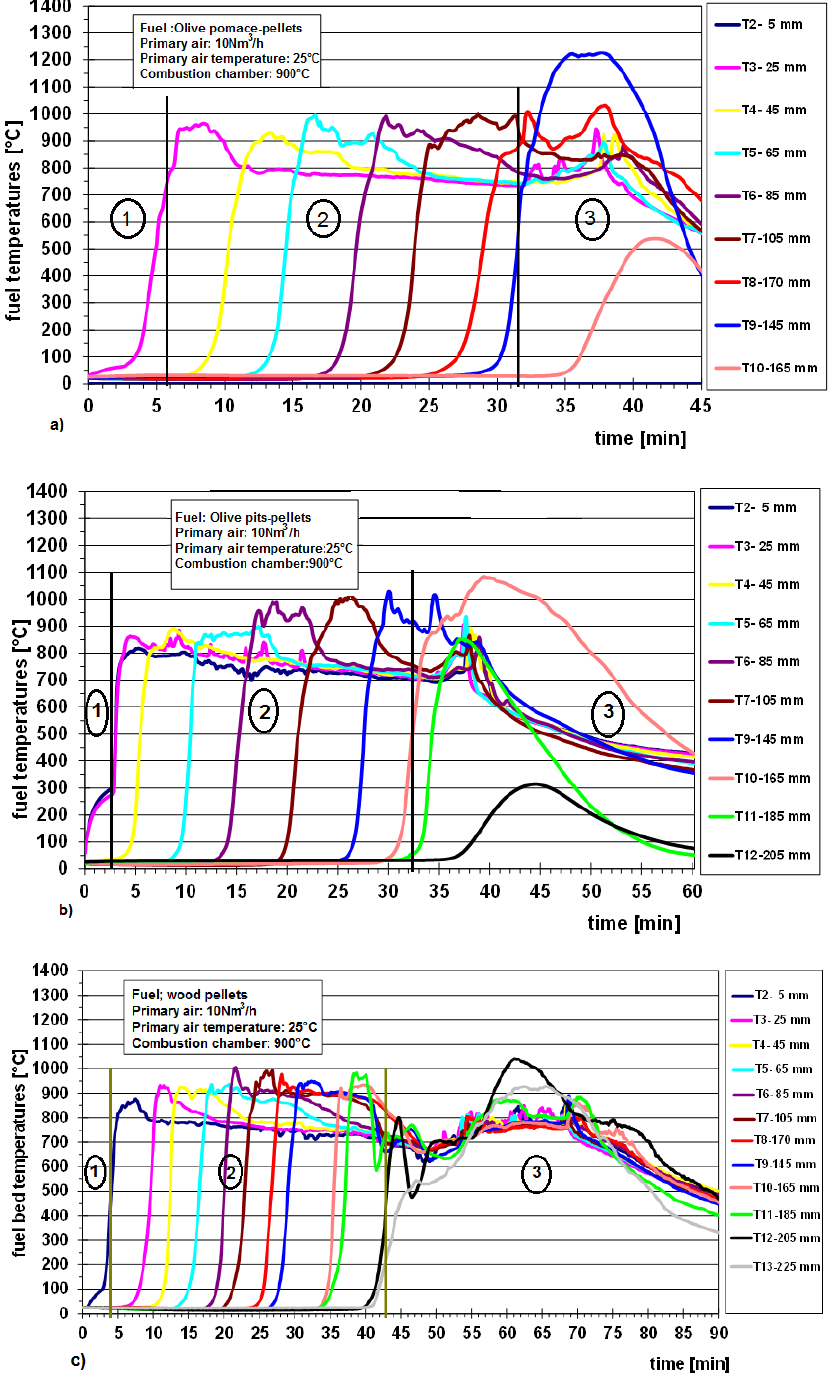
Figure 3. Thermocouples’ readings during the passage of the flame front. ( a ) 100% olive pomace (OP); ( b ) 100% olive pits; ( c ) standard biofuel wood pellets.